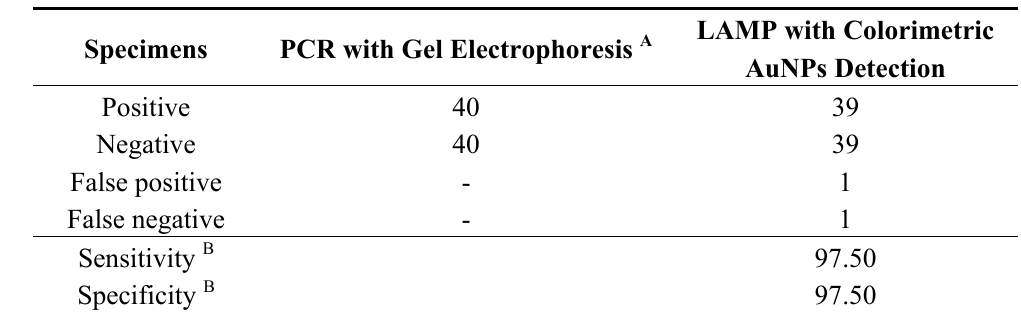
Table 2. Comparison of PCR with LAMP and AuNPs of p30 gene from 80 specimens (N =